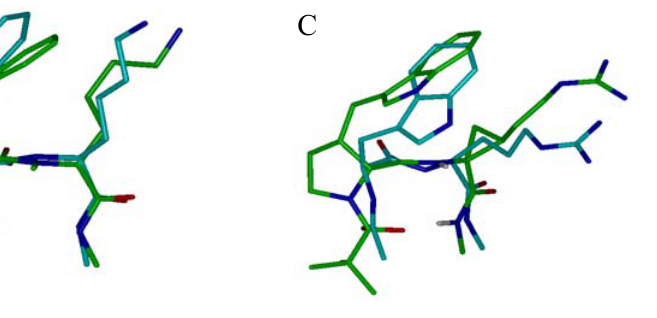
Figure 5. Comparison of turn mimetics NMR structures with selected  -turns from PDB structures. The turn mimetics are pseudotetrapeptides of sequence Piv-D-Xaa-L-Yaa- NHMe with Xaa = 3- cis -prolinoleucine ( A ) or 3- cis -prolinohomotryptophane ( B , C ) and Yaa = NMePhe ( A ), NMeLys ( B ) or cyclopropylarginine ( C ). The peptidomimetics structures are superimposed to the following structures: A , Leu-Phe  -turn of glycogen phosphorylase (PDB entry 3GPB); B , Trp-Lys  -turn of a somatostatin analog (PDB 1SOC); C , Trp-Arg  -turn of tendamistat (PDB